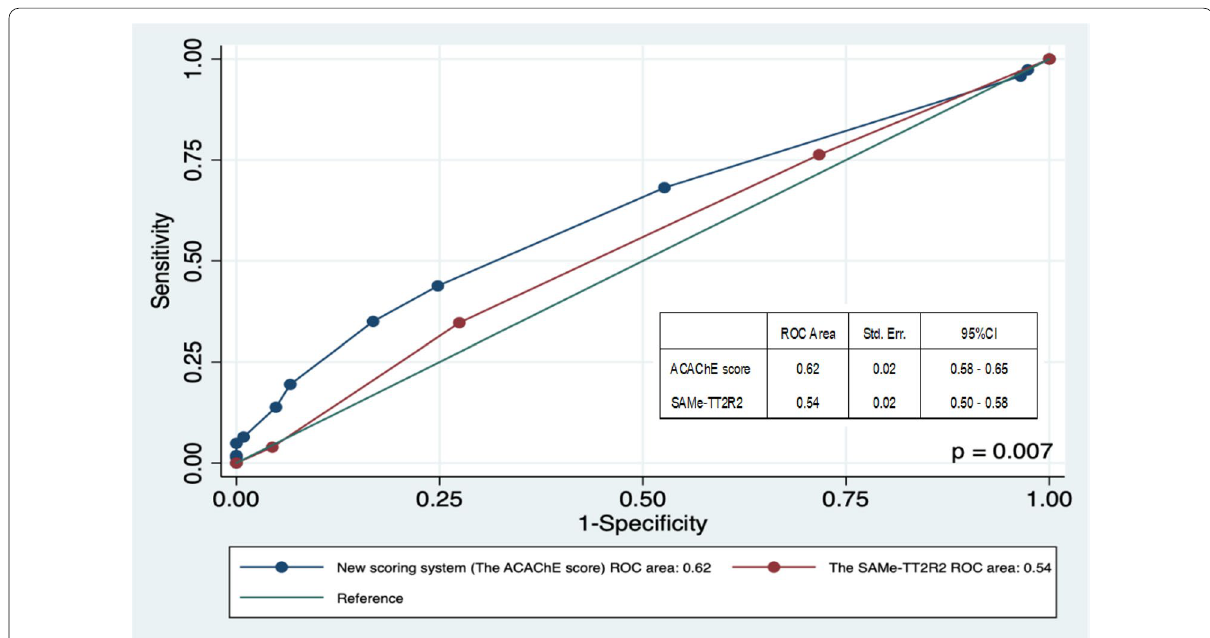
Fig. 2 Receiver-operating characteristic (ROC) curves demonstrating discrimination performance of the new scoring system (ACAChE score) in comparison with the SAMe-TT2R2 score for time in therapeutic range (TTR) <